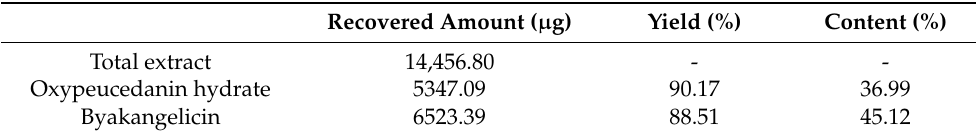
Table 7. Contents of oxypeucedanin hydrate and byakangelicin in the